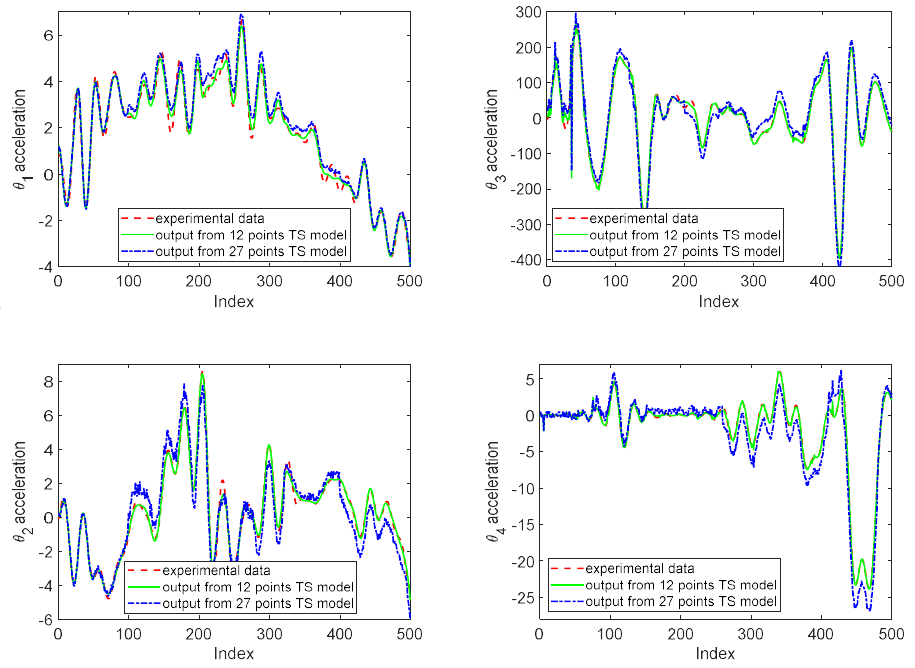
Figure 5. Experimental data and predicted outputs from the T-S fuzzy models.